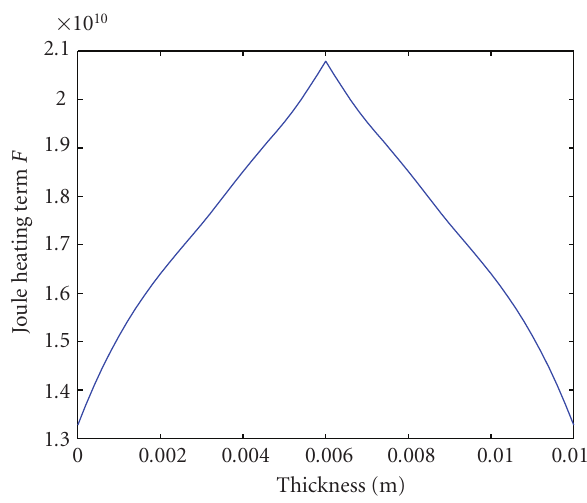
Figure 4.5. Example 1: the Joule heating source term as a function of x at a fixed time for the case R g = 10 − 9